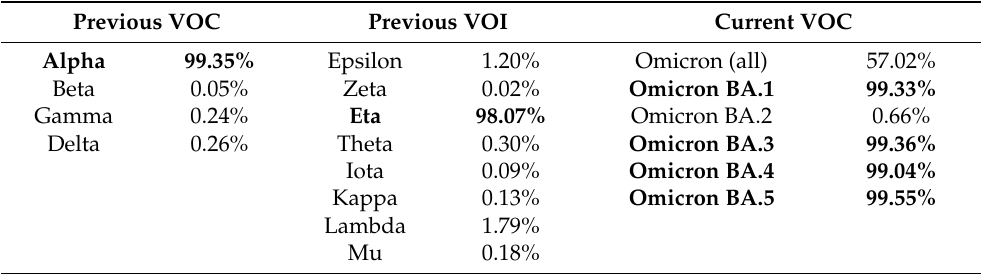
Table 1. Proportion of S protein deletion at amino acid position 69–70 in previous and current VOC/VOI. Variants in bold predominantly contain S:del69–70. Worldwide data obtained from CoV-Spectrum.org, analysed on 25 July 2022 [17]. Previous VOC Previous VOI Current VOC Alpha 99.35% Epsilon 1.20% Omicron (all) 57.02% Beta 0.05% Zeta 0.02% Omicron BA.1 99.33% Gamma 0.24% Eta 98.07% Omicron BA.2 0.66% Delta 0.26% Theta 0.30% Omicron BA.3 99.36% Iota 0.09% Omicron BA.4 99.04% Kappa 0.13% Omicron BA.5 99.55% Lambda 1.79% Mu